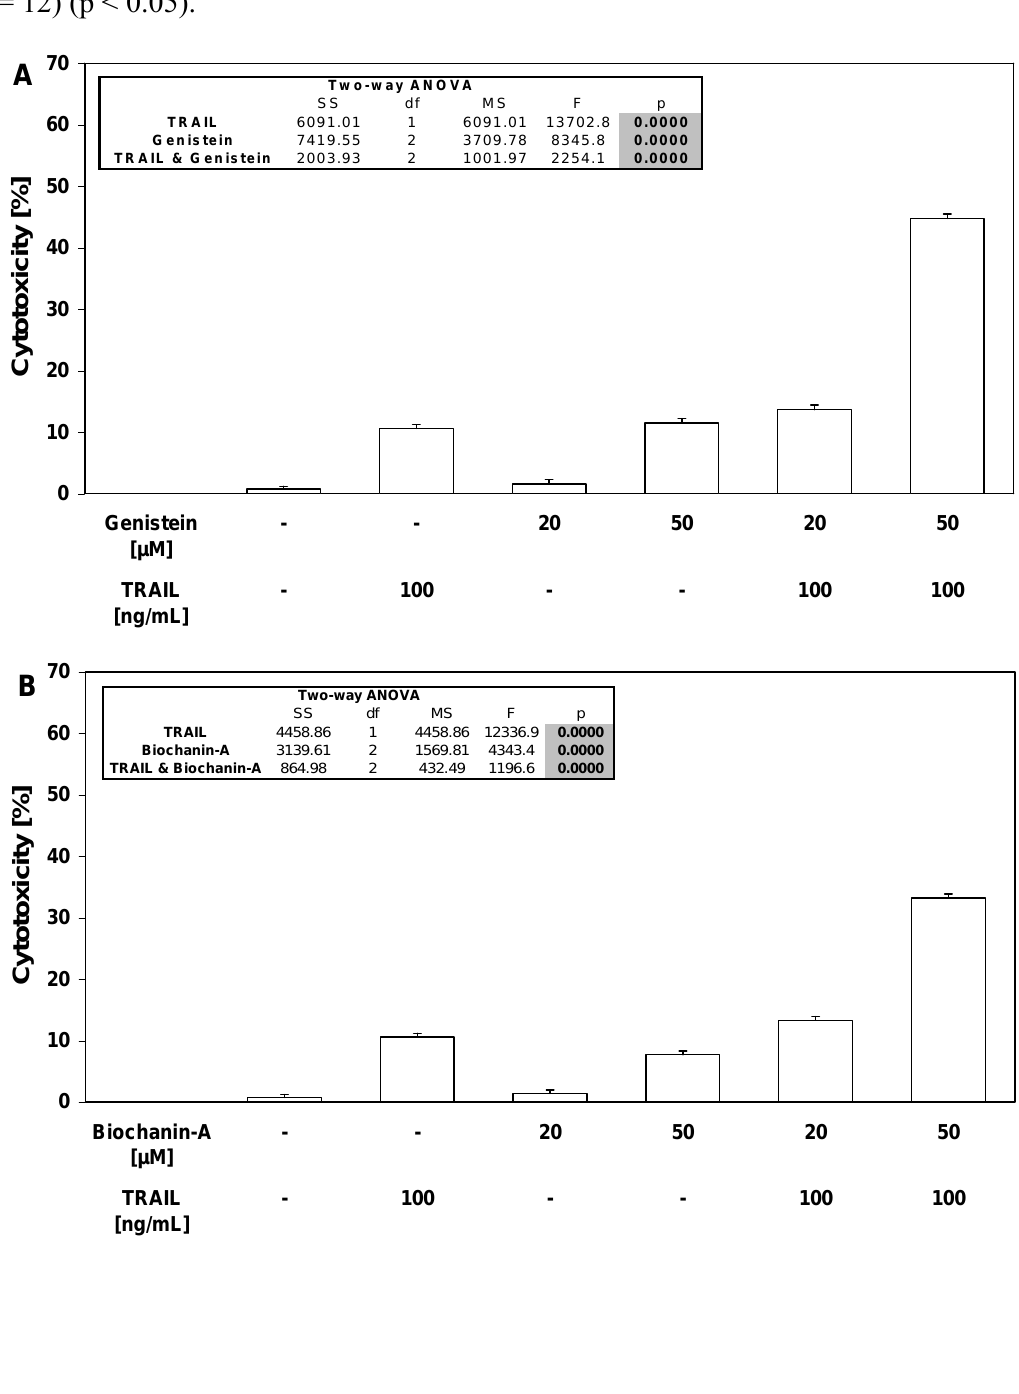
Figure 4. Cytotoxic activity of TRAIL in combination with isoflavones in HeLa cancer cells. The cancer cells were incubated for 48 hours with TRAIL at the concentration of 100 ng/mL and isoflavone: ( A ) genistein, ( B ) biochanin-A, ( C ) neobavaisoflavone at the at the concentrations of 20 μ M and 50 μ M, ( D ) comparison between isoflavones at concentration 50 μ M. The percentage of cell deaths was measured by MTT cytotoxicity assay. The values represent mean ±SD of three independent experiments performed in quadruplicate (n = 12) (p <